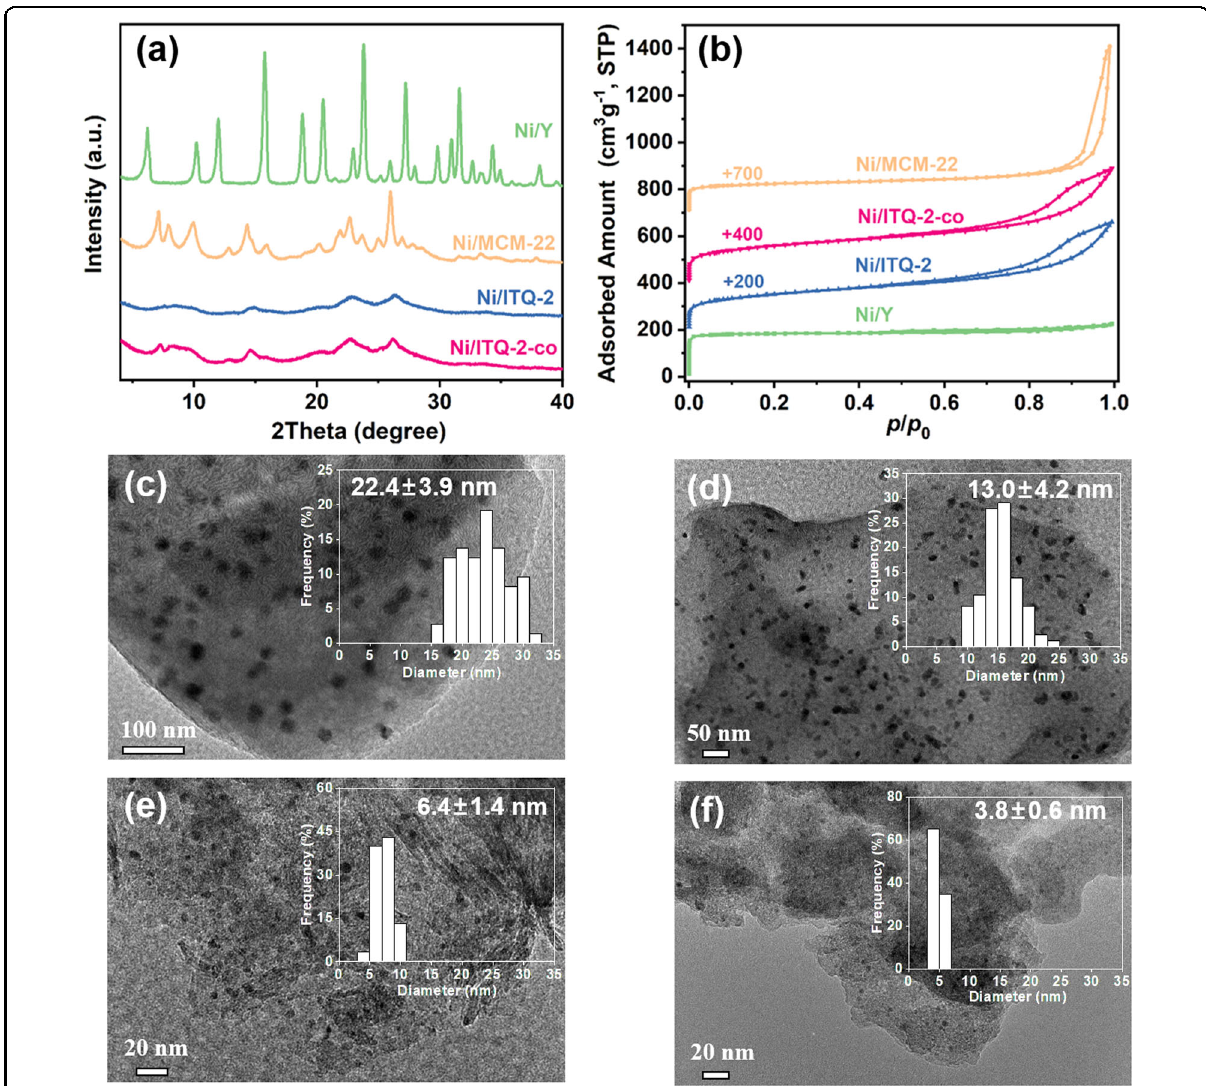
Fig. 1 Textural properties of prepared samples and the distribution of Ni clusters on zeolite supports. (a) XRD patterns for the Ni/zeolites; ( b) N 2 adsorption/desorption isotherms of the Ni/zeolites; transmission electron microscopy (TEM) images of Ni/Y ( c ), Ni/MCM-22 ( d ), Ni/ITQ-2 ( e ) and Ni/ ITQ-2-co ( f ). The corresponding size distributions of the Ni clusters were obtained by measuring over 300 Ni